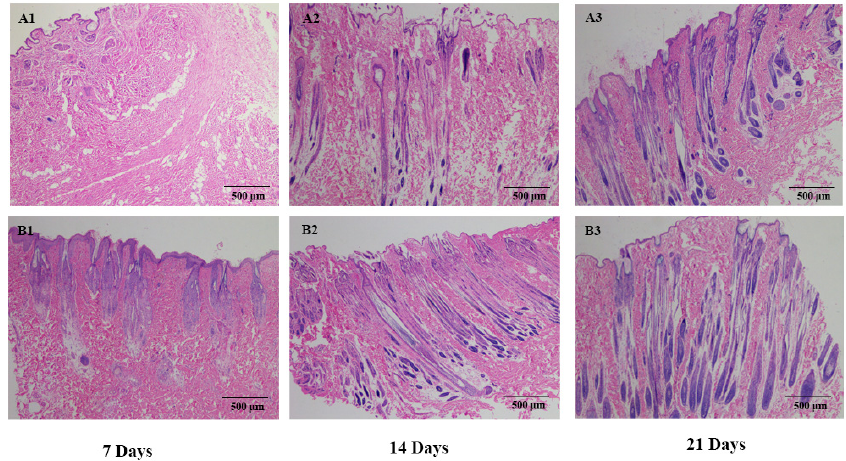
Figure 5. HE staining of sequential skin samples. ( A1 – A3 ) Control group at 7, 14 and 21 days. ( B1 – B3 ) Combined treatment group at 7, 14 and 21 days.